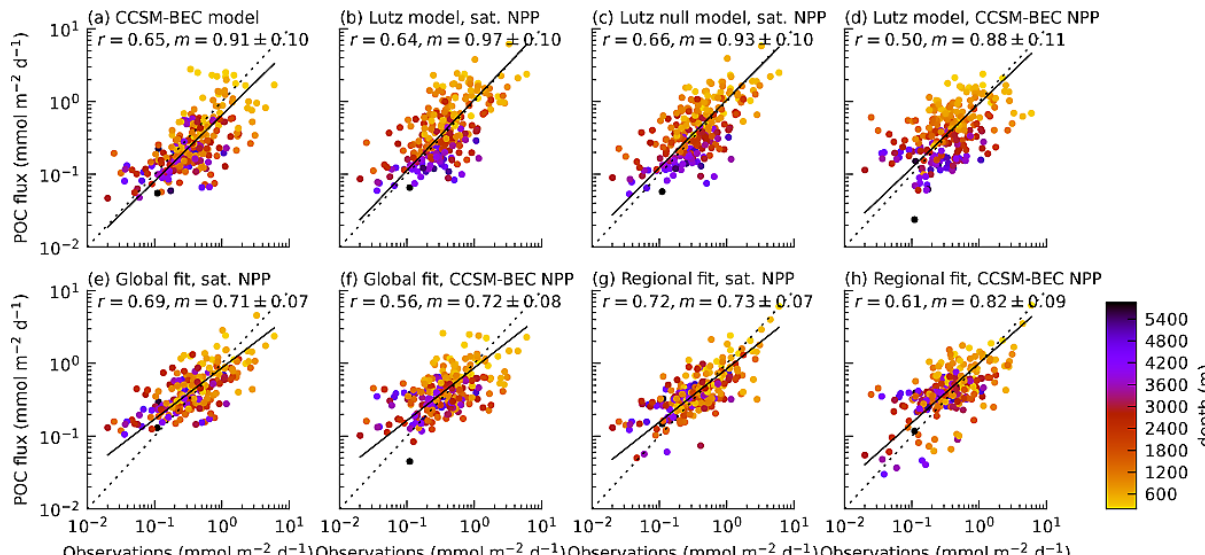
Fig. 3. POC flux estimates at sediment trap locations plotted against observations from the Lutz data set: (a) CCSM-BEC model, (b) Lutz model using satellite NPP, (c) Lutz null model using satellite NPP, (d) Lutz model using CCSM–BEC NPP; (e) and (f) show estimates from fit of exponential curve (Eq. 1) to Lutz data set (all data points combined) using NPP from satellite and CCSM–BEC, respectively; (g) and (h) show estimates from fit of exponential curve (Eq. 1) to Lutz data set for each region of the model domain (Fig. 1) using NPP from satellite and CCSM–BEC, respectively. In (g) and (h) , the regions with no observations or poor fit use parameter values from the global fit ( e and f ). Solid black lines show the type II linear regression of the log 10 -transformed data. The correlation coefficient ( r ) and regression slope ( m ) are shown in each panel. Color scale indicates depth of sediment